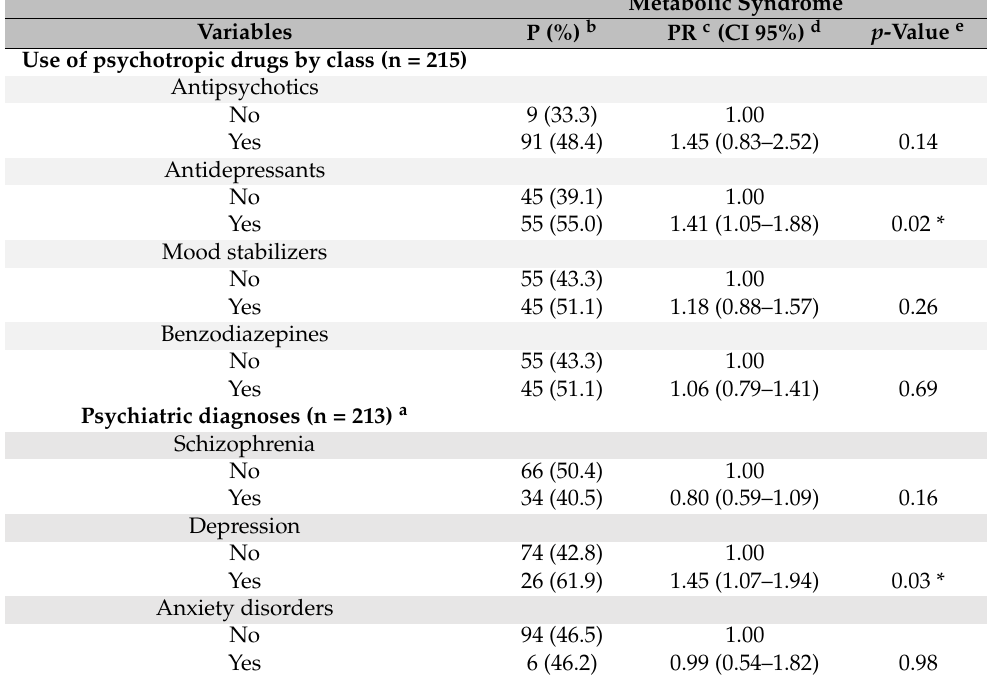
Table 2. Gross prevalence ratio of metabolic syndrome and its 95% confidence intervals according to psychiatric diagnosis and use of psychiatric drugs in the users of a Psychosocial Care Center, Bahia, Brazil, 2019 (n =